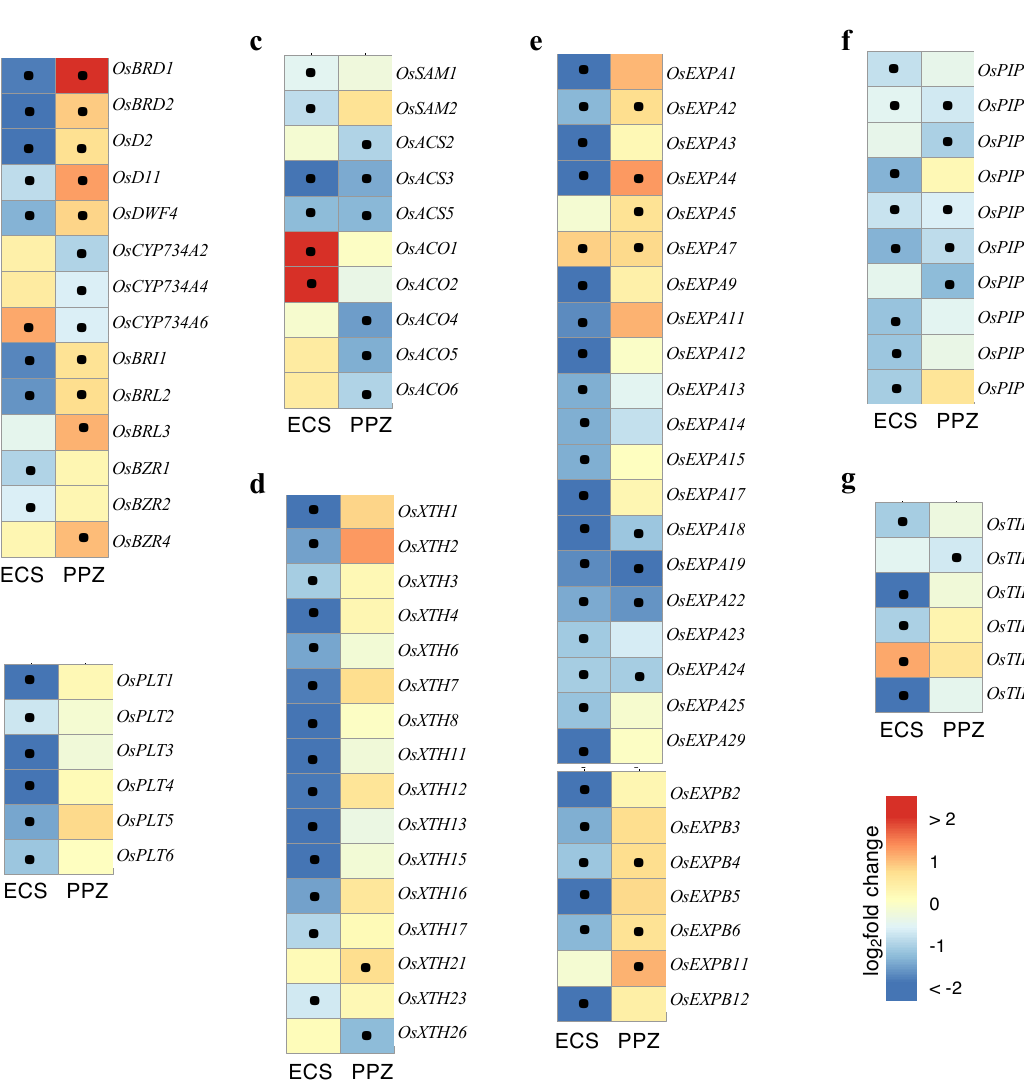
BR biosynthetic genes ( OsBRD1, OsBRD2, OsD2, OsD11 and OsDWF4 ) were repressed by ECS and induced by PPZ, whereas BR catabolic genes ( OsCYP73A2, OsCYP73A4 and OsCYP73A6 ) were induced by ECS and repressed by PPZ (Figure 4a). In addition, ECS repressed and PPZ induced expression of BR receptor genes ( OsBRI1, OsBRL2 and OsBRL3 ) and BZR family transcription factors ( OsBZR1, OsBZR2 and OsBZR4 ), with the exception of OsBZR4 , which was induced by ECS (Figure 4a). The expression of these BR biosynthetic, catabolic and signaling genes, which showed negative feedback regulation by the BR signaling pathway [15], corroborated that BR signaling was activated in the ECS-treated roots and inhibited in the PPZ-treated roots.